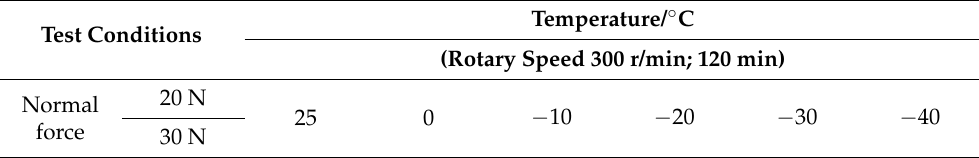
Table 2. Related parameters of the test